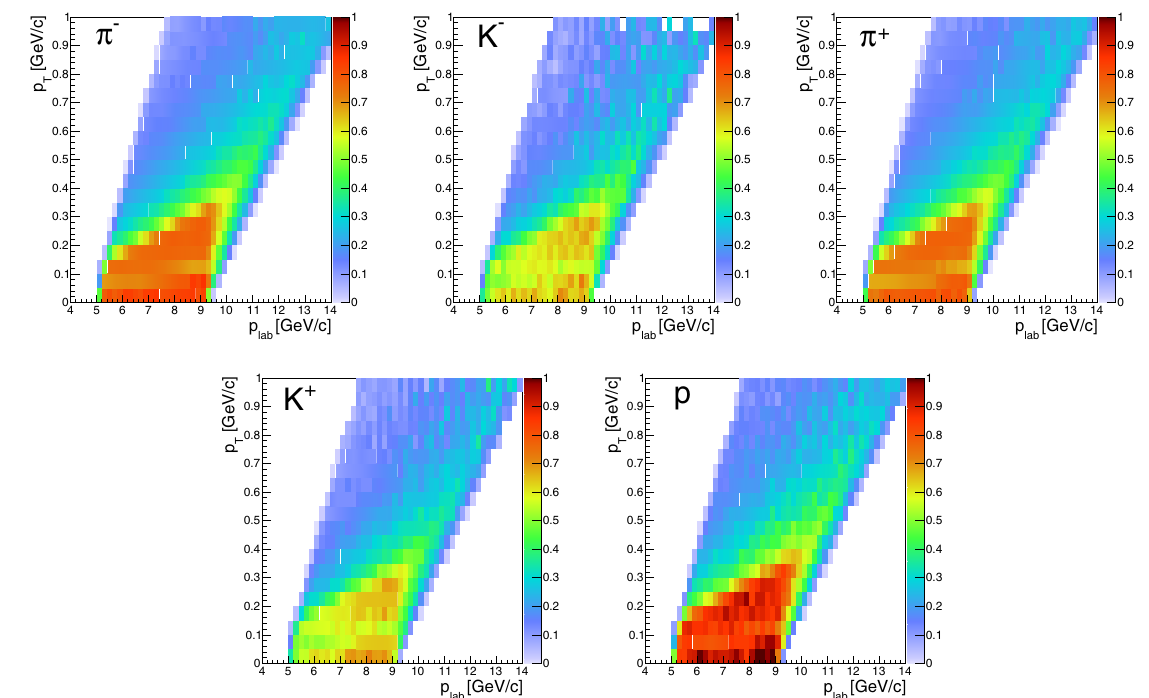
Fig. 46 Acceptance for tracks extrapolating to a pixel of the ToF-L or ToF-R walls and having a last measured point in the two last padrows of the MTPC for p + p interactions at 158 GeV / c